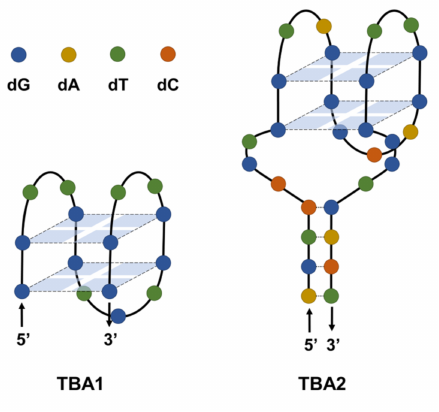
Figure 1. The G-quadruplex structure assembled by Hoogsteen hydrogen bonding of thrombin binding aptamer 1 (TBA1) and thrombin binding aptamer 2 (TBA2) and their deoxynucleotide